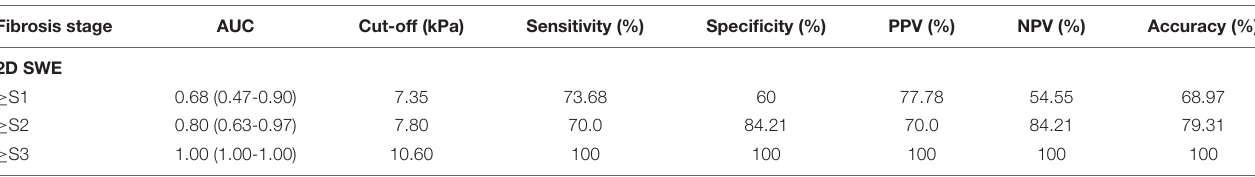
TABLE 3 | Accuracy of two-dimensional shear wave elastography (2D-SWE) in predicting liver fibrosis in pediatric recipients with stable serum alanine aminotransferase (ALT) level (ALT (cid:53) 1 ULN) after liver transplantation (LT). Fibrosis